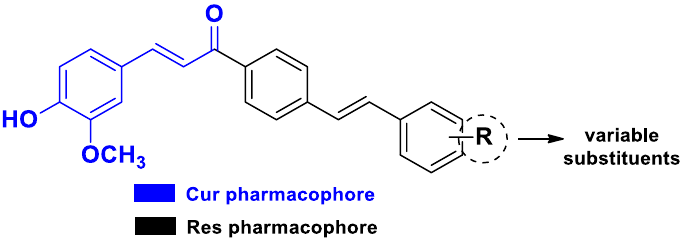
Figure 18. Structure of the Cur – Res hybrid derivatives developed by Hernández et al. [54].